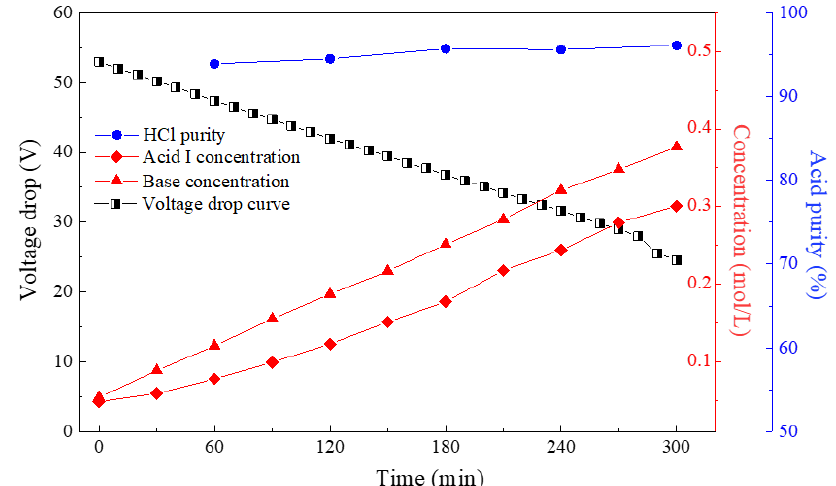
Figure 8. The SBMED performances, i.e., voltage drop curve as a function of time, HCl purity in the acid I compartment, acid concentration curve in the acid I compartment and base concentration curve in the base compartment using simulated seawater.